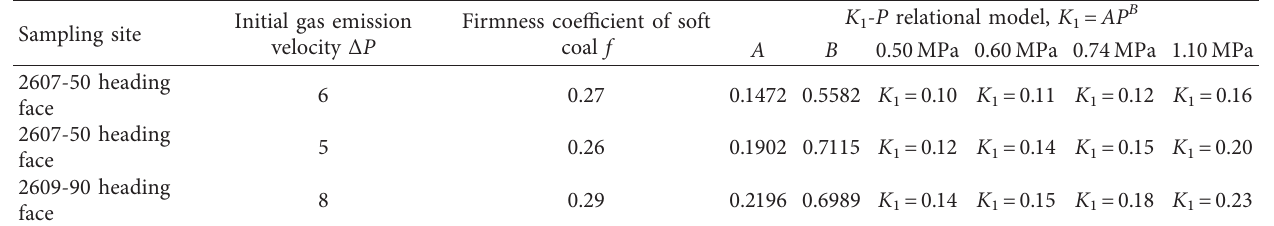
Table 3: Gas parameters of coal found by laboratory investigation.